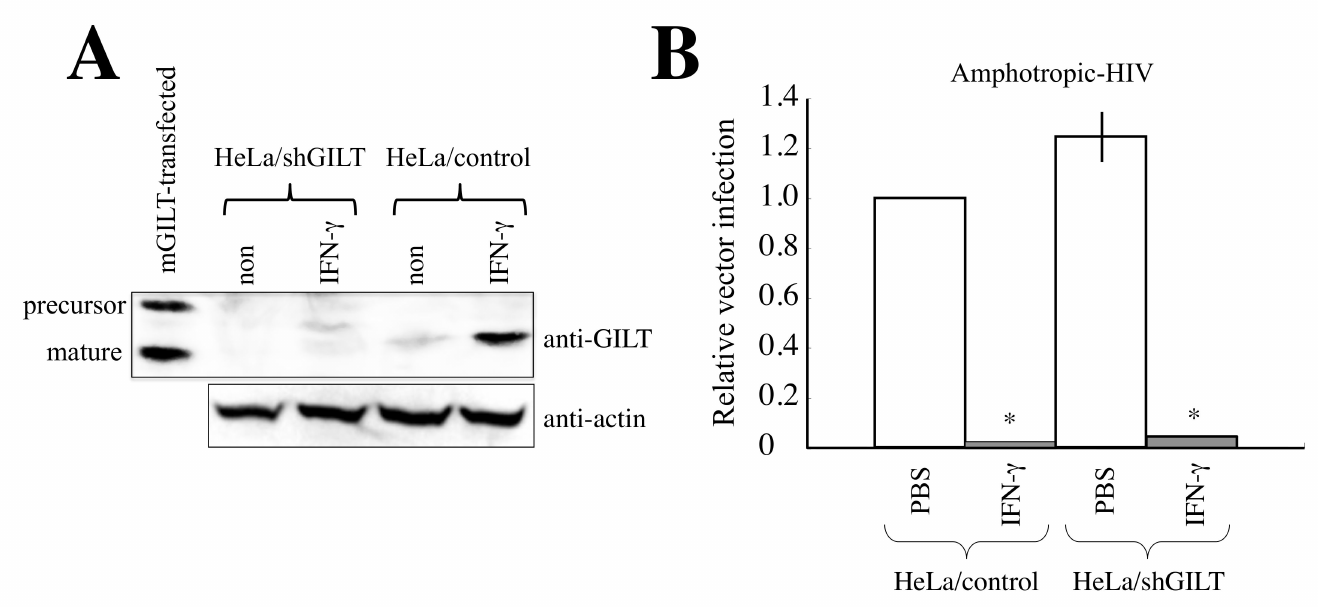
Figure 1. Unknown cellular factors other than GILT inhibit amphotropic MLV-pseudotyped HIV-1- based vector infection in HeLa cells. ( A ) HeLa/control and HeLa/shGILT cells were treated with γ -IFN (0.2 µ g/mL). Cell lysates were prepared 3 days after the treatment. The cell lysates were analyzed by Western blotting. ( B ) HeLa/control and HeLa/shGILT cells were treated with γ -IFN for 3 days and were inoculated with amphotropic MLV-pseudotyped HIV-1-based vector. Transduction titers in HeLa/control cells are always set to 1, and relative values ± SD are indicated. Asterisks indicate significant differences compared to PBS-treated cells (see Section 2). This experiment was performed in